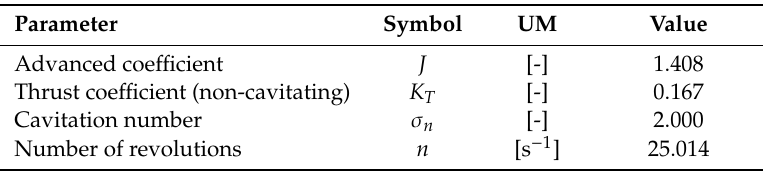
Table 12. Cavitation observations. Test case 2.3.3 in [46].